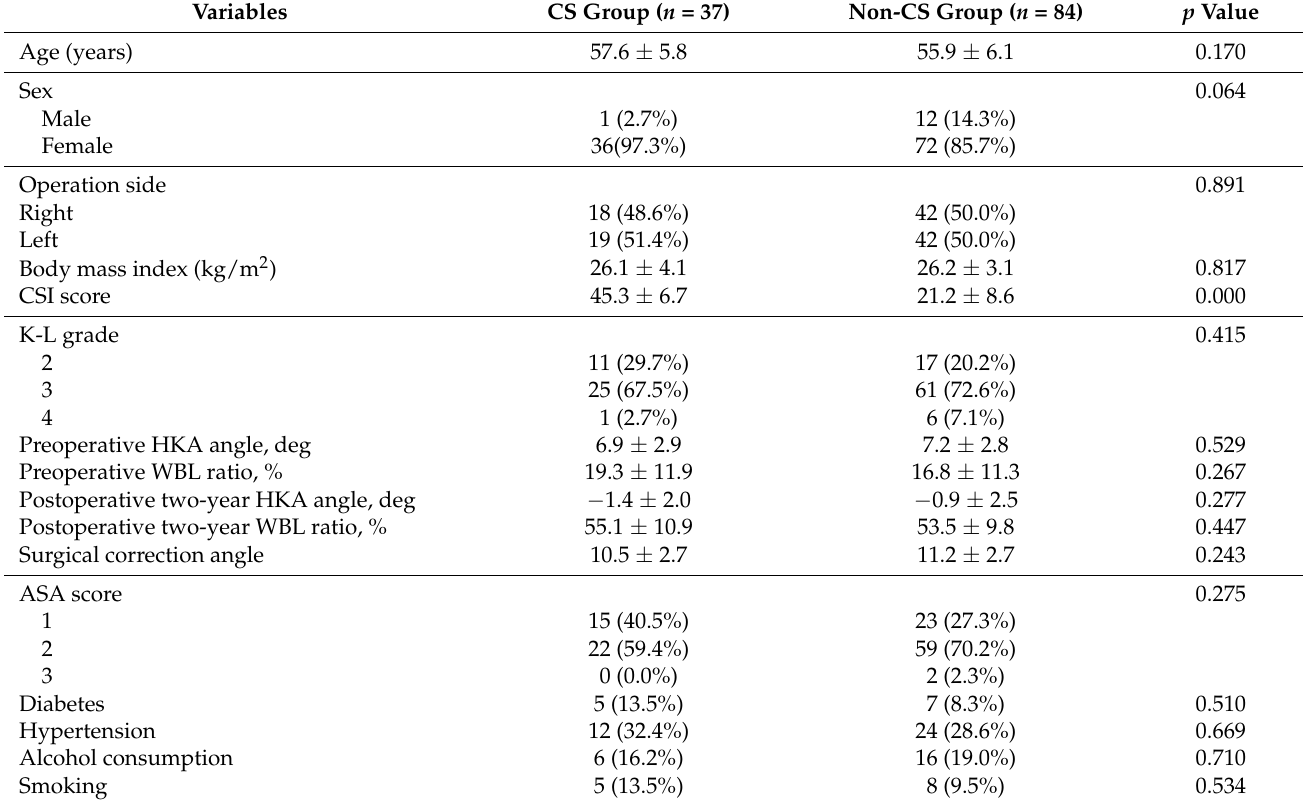
Table 1. Patient characteristics.